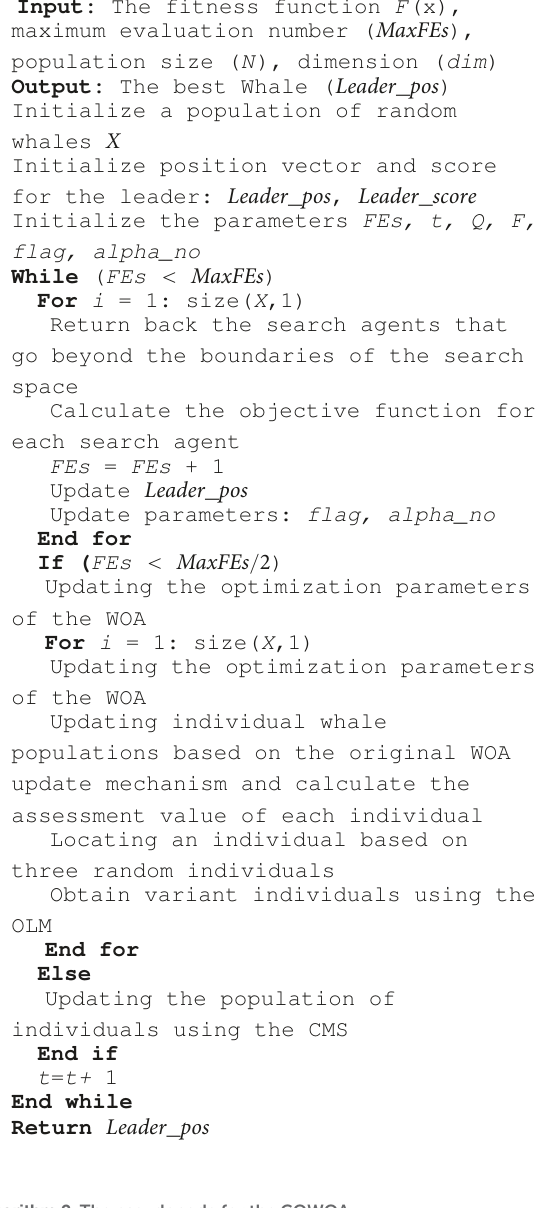
Algorithm 2. The pseudocode for the